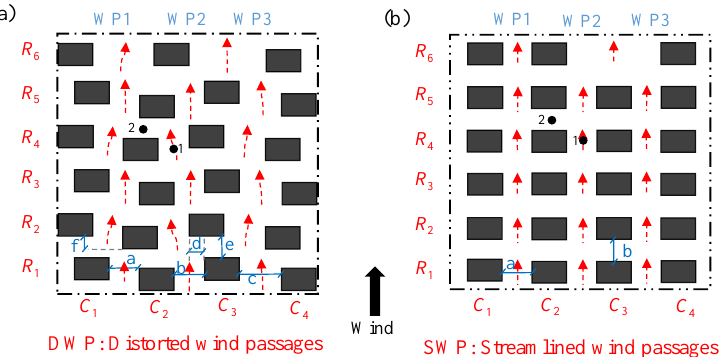
Figure 5. Schematic diagrams of model arrangement for cases ( a ) DWP: distorted wind passages and ( b ) SWP: streamlined wind passages. The spatial average domain is presented as the area of dot-dashed line with the size of 1.6 × 1.6 m 2 . Two points, P1 and P2 are selected as representatives to denote the wake and wind passage